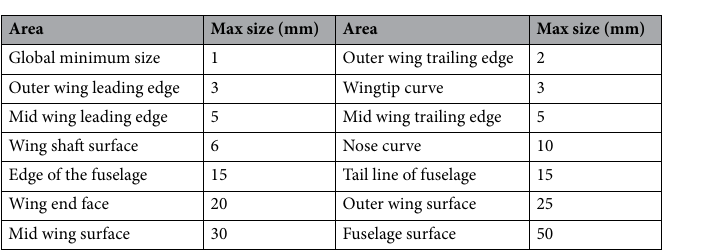
Figure 5. Meshing of the surface of each part of the aircraft.